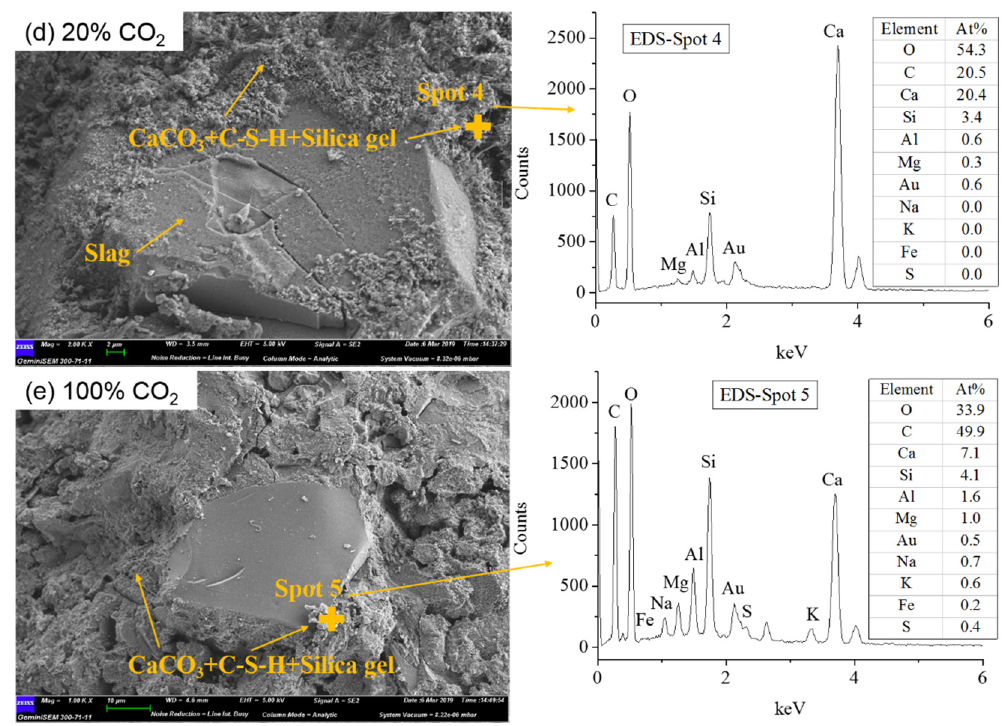
Figure 6. SEM images of slag blended cement pastes before and after carbonation with different concentrations: ( a ) uncarbonated, ( b ) 0.03% CO 2 , ( c ) 3% CO 2 , ( d ) 20% CO 2 , ( e ) 100% CO 2 .